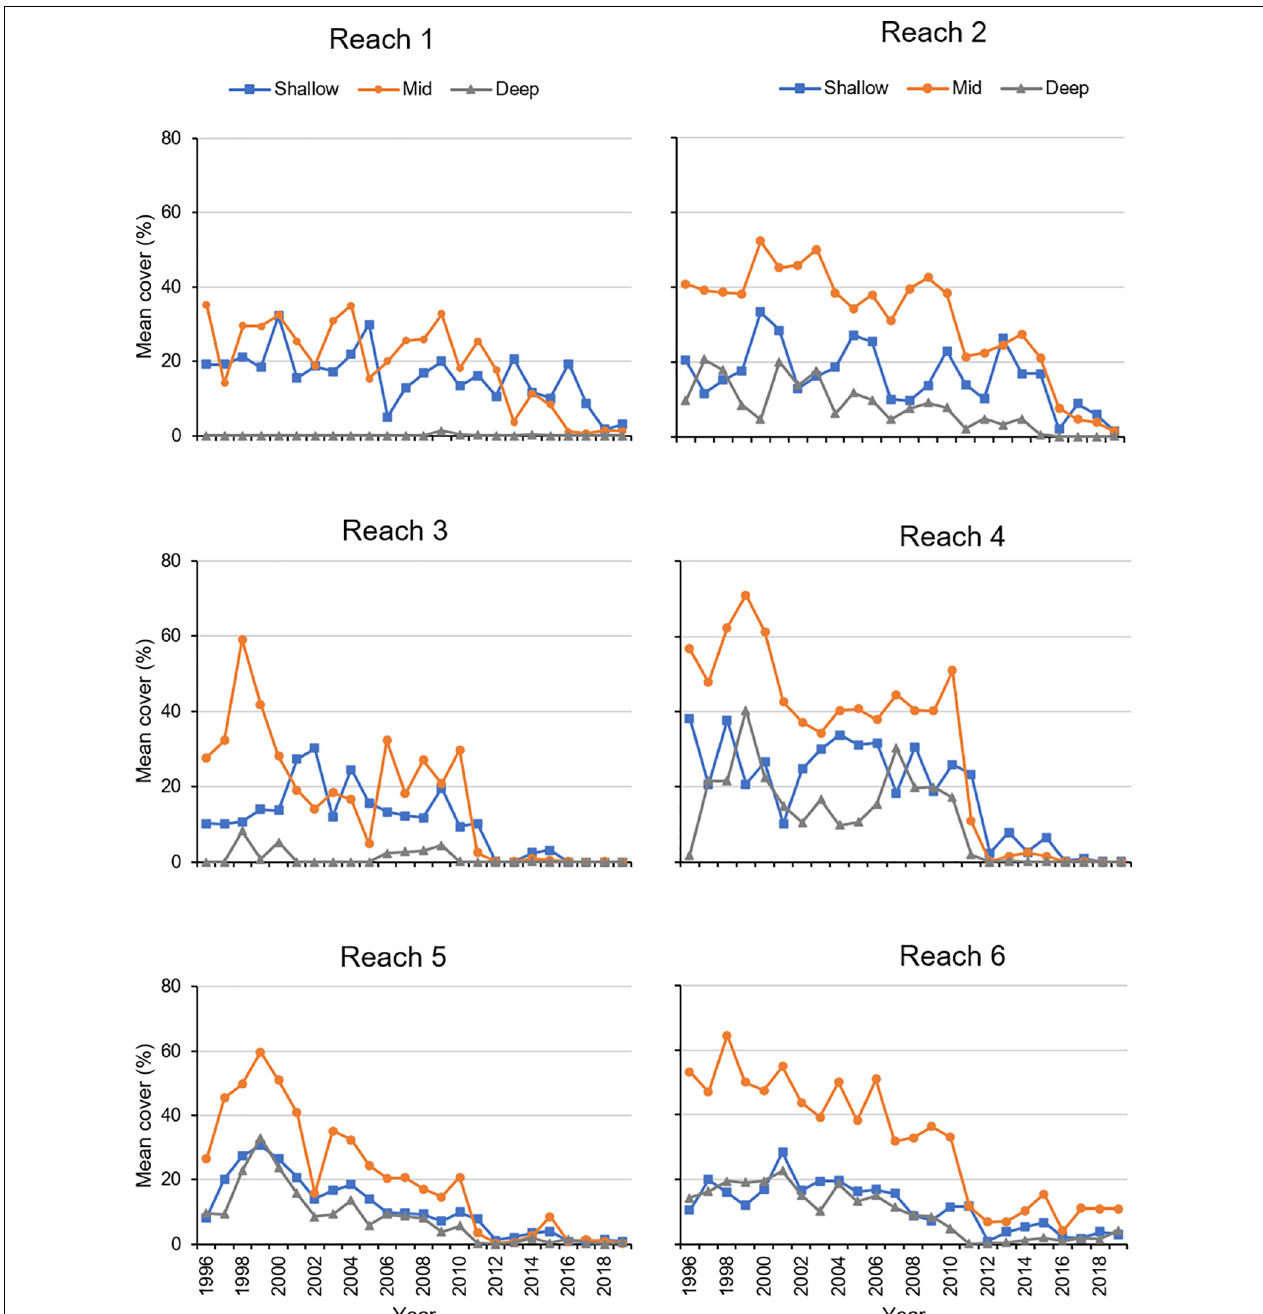
FIGURE 10 | Mean percent cover of seagrass during summer in three depth zones. Shallow = 0.1–0.4 m, Mid = 0.5–0.9 m, Deep = 1.0–2.0+